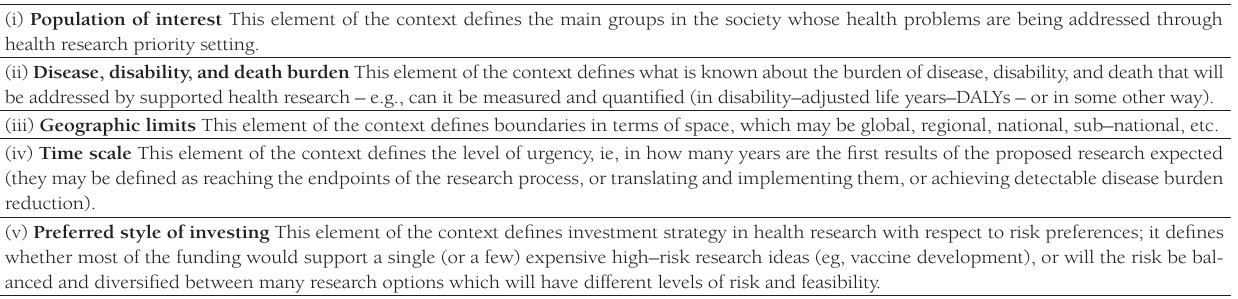
Table 3. Elements of the context in which health research prioritization takes place; they need to be clearly defined and communicat- ed to invited technical experts prior to listing and scoring health research ideas